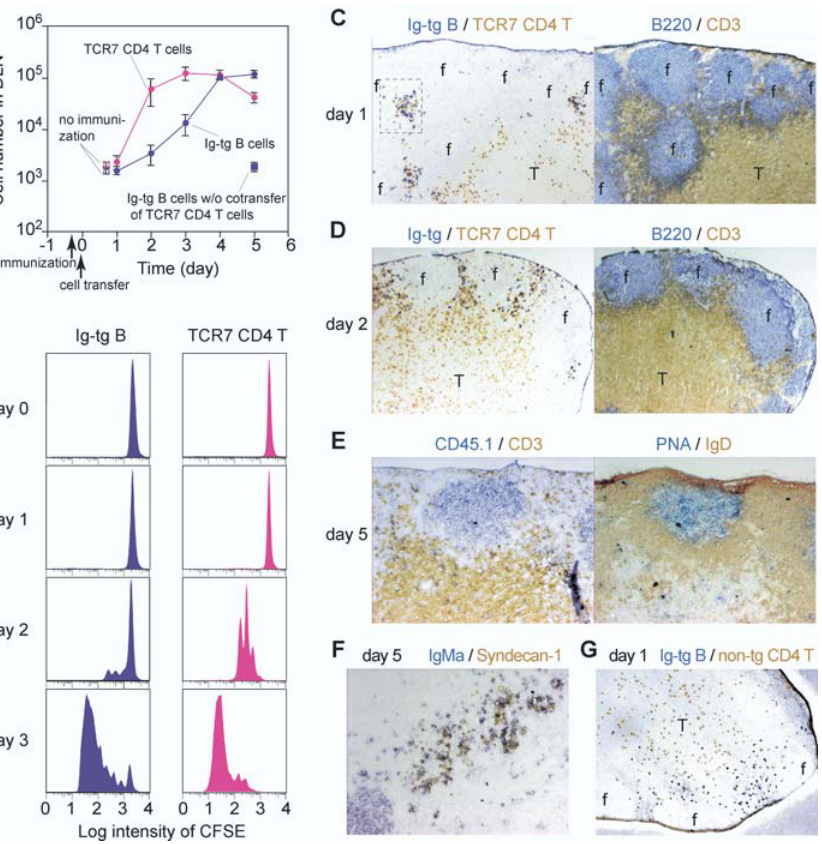
Figure 5. Kinetics of HEL-Specific B Cell Expansion and Differentiation in the Presence of HEL-Specific TCR-Transgenic Helper T Cells (A) Numbers of Ig-tg B cells and TCR7 CD4 þ T cells in draining (two inguinal) lymph nodes plotted against time after cell transfer. Shown are means 6 standard errors of more than three experiments. Immunization of recipient mice with HEL in adjuvant was done 8 h before cell transfer. (B) Time course of B and T cell division in draining lymph nodes, determined by CFSE dilution. (C–F) Immunohistochemical analysis of draining lymph nodes at days 1–5 following immunization, stained as indicated. Note redistribution of B cells into interfollicular clusters in the presence of helper T cells. An enlarged version of the boxed region in (C) is shown in Figure S2. (G) Distribution of Ig-tg B cells at day 1 in the absence of helper T cells, stained as indicated. Objective magnification in (C), (D), and (G), 5 3 , and in (E) and (F), 10 3 . DOI: